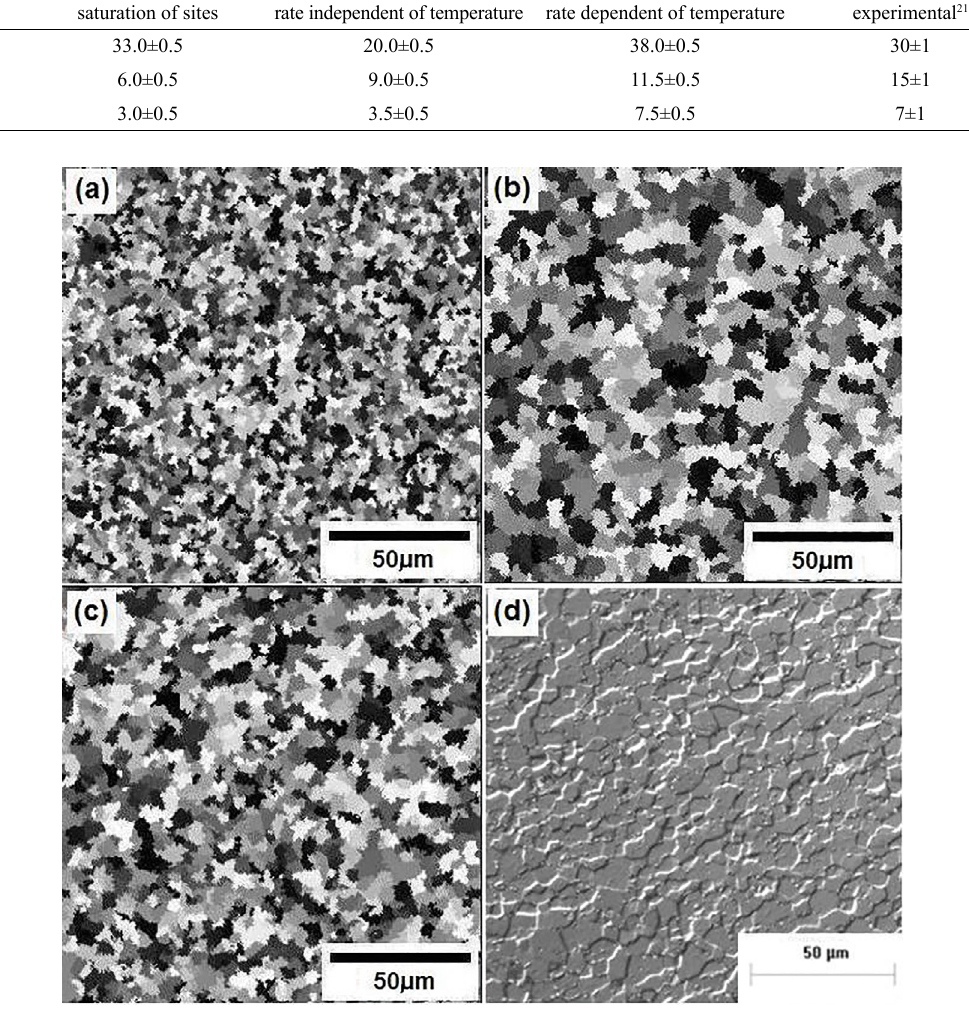
Figure 4: Microstructures at the end of primary recrystallization at 948 K: generated by simulation of these nucleation mechanisms: site saturation (a), rate independent of annealing temperature (b), annealing temperature-dependent rate (c), and rate obtained experimentally (d) in 21 . Table 3: Comparison of simulated and experimental results for the average diameter of recrystallized grains at the end of primary recrystallization, at each temperature and for each nucleation mechanism. Average diameter of recrystallized grains